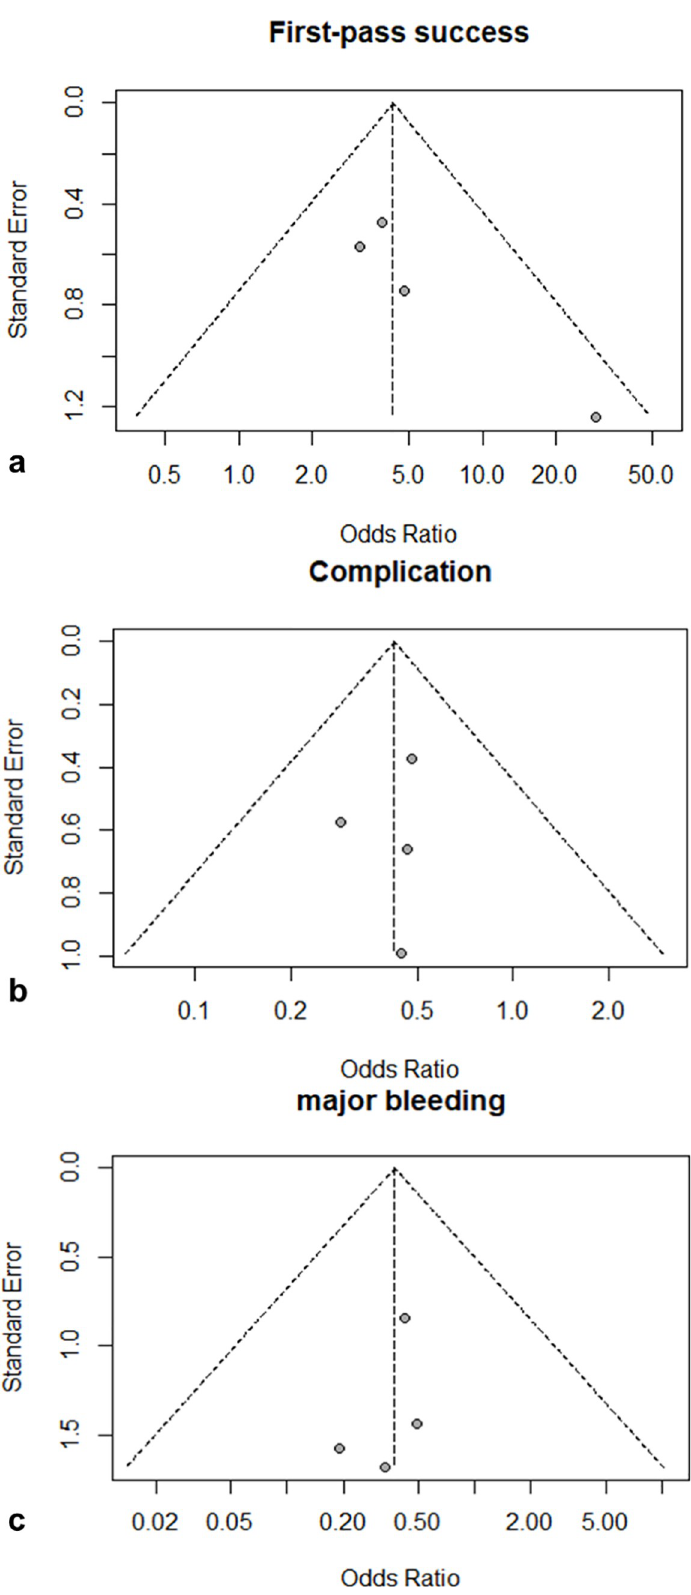
Fig 5. Funnel plots of first-pass success (a), complications (b), and major bleeding (c). https://doi.org/10.1371/journal.pone.0258972.g005 PLOS ONE | https://doi.org/10.1371/journal.pone.0258972 October 28,